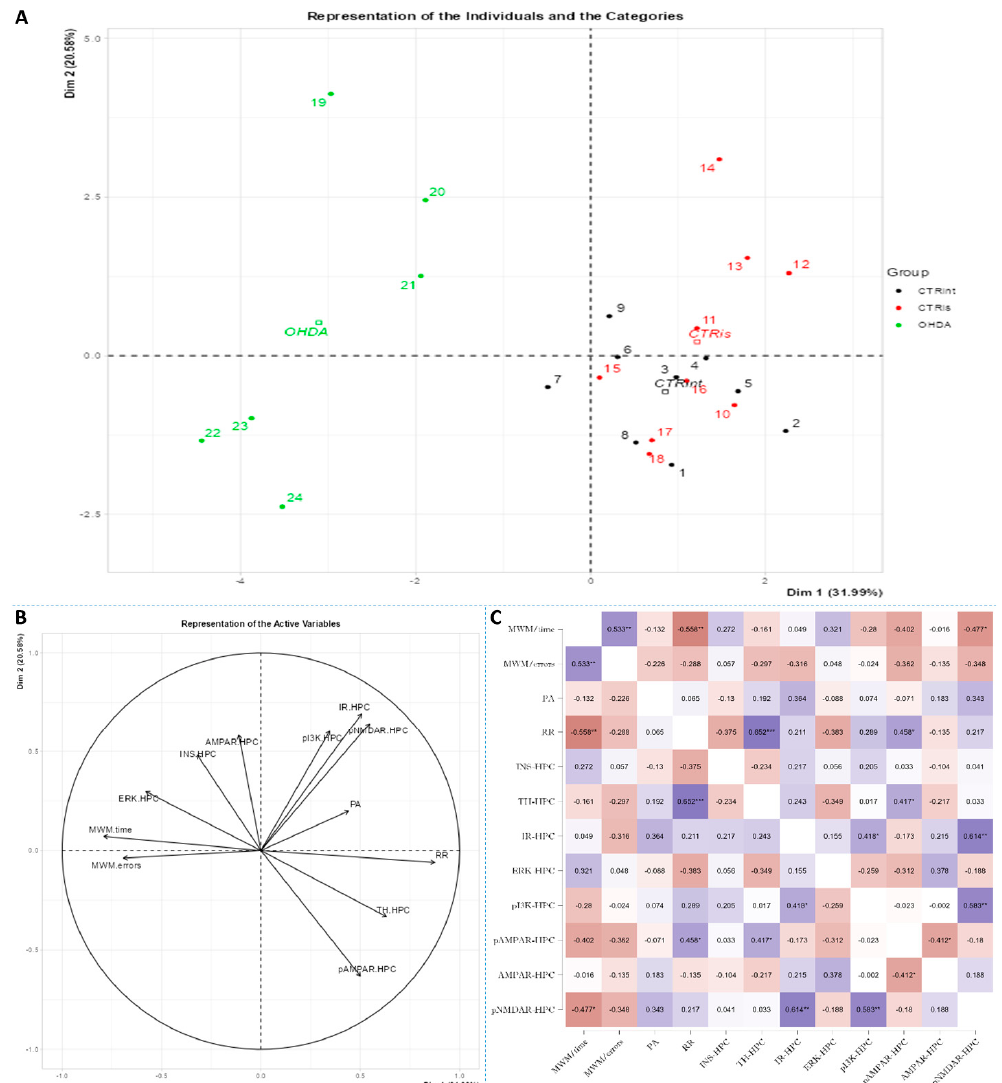
Figure 5. Principal component analysis and Spearman’s rank correlation of observed parameters in the hippocampus 3 months after intrastriatal administration of 6-OHDA. Hippocampal (HPC) principal component analysis is represented as a biplot ( A ) with coordinates of individual animals in respect to the 1st and 2nd dimensions (principal components) and a biplot graph of the variables’ contributions to the 1st and the 2nd principal component ( B ). Groups are represented in different colors: intact control (CTRint, black), sham-treated control (CTRis, red), animals treated intrastriatally with 6-hydroxydopamine (OHDA, green) ( A ). Spearman’s rank correlation of HPC parameters is represented as Spearman’s rho heatmap ( C ) with statistically significant correlations indicated with * p < 0.05, ** p < 0.001, *** p < 0.001. Dim 1-1st dimension; Dim 2-2nd dimension; MWM-Morris Water Maze; PA-Passive Avoidance; RR-Rotarod; INS-insulin; TH-tyrosine hydroxylase; IR-insulin receptor; ERK-extracellular signal-regulated kinase; pI3K-phosphoinositide 3-kinases; AMPAR- α -amino-3- hydroxy-5-methyl-4-isoxazolepropionic acid receptor; NMDAR-N-methyl-D-aspartate